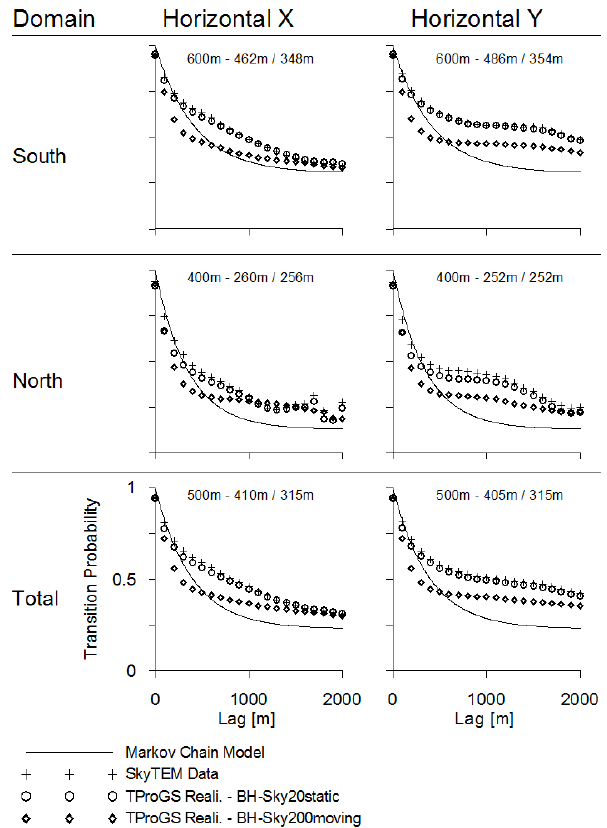
Figure 9. The simulated transition probabilities for the south, north and total domain are compared with the SkyTEM data and the fitted MCM. The results for two soft conditioning data set are shown: BH-Sky20static and BH-Sky200moving. The simulated TP and the MCM at lag 100m are compared to quantify the underestimation of a sand lens. The TP values are mean values based on 10 realizations. The defined length of a sand lens (X) and the mean simulated length for the BH-Sky20static (Y) and BH-Sky200moving scenario (Z) are given in each graph. (Xm –